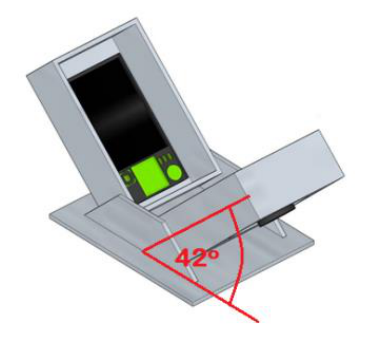
Figure 3 Oblique camera housing